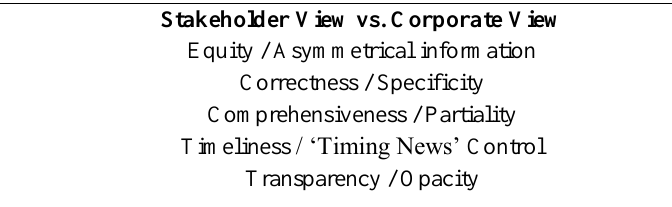
Figure 4: Stakeholder View and Corporate View Stakeholder View vs. Corporate View Equity / Asymmetrical information Correctness / Specificity Comprehensiveness / Partiality Timeliness / ‘Timing News’ Control Transparency /